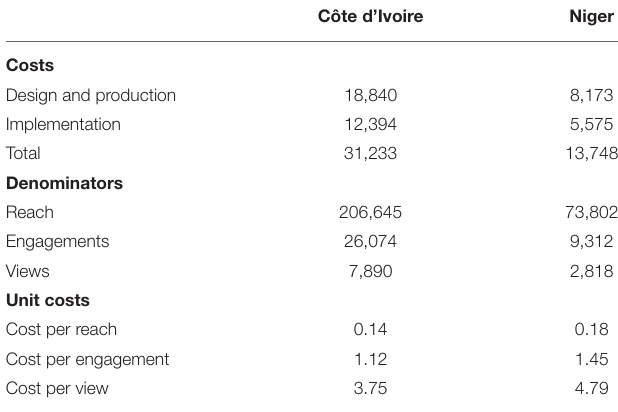
TABLE 3 | Costs, denominators, and unit costs